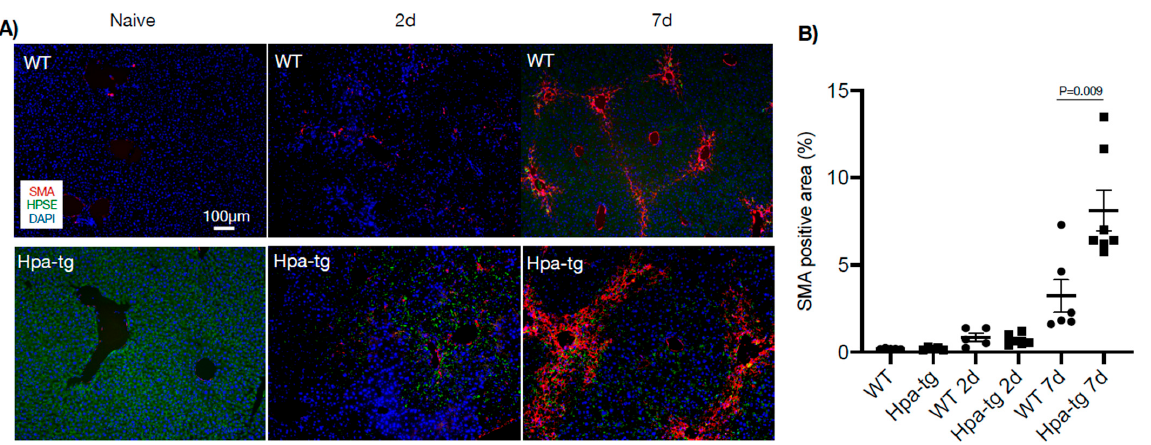
Figure 5. Immunohistostaining of alpha-smooth muscle actin (SMA, red) in paraffin-embedded liver sections. ( A ) SMA was non-detectable in naïve mice and a trace amount was detected 2 days after CCL4 induction. ( B ) Quantification of the positive areas by ImageJ revealed larger positive areas in Hpa-tg vs. WT liver. More than 10 random fields were quantified for each mouse ( n = 4 per group), and the WT naïve value was set arbitrarily to a value of 1. Heparanase (HPSE, green) was detected only in the Hpa-tg